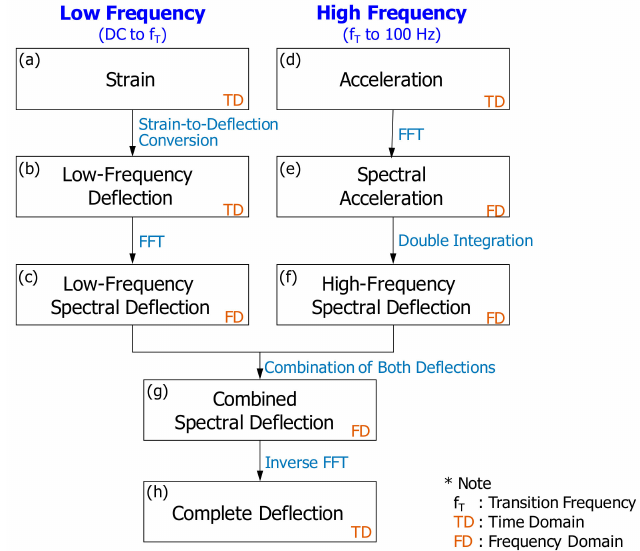
Figure 1. Overview of the evaluation of Pseudo-Deflection Method